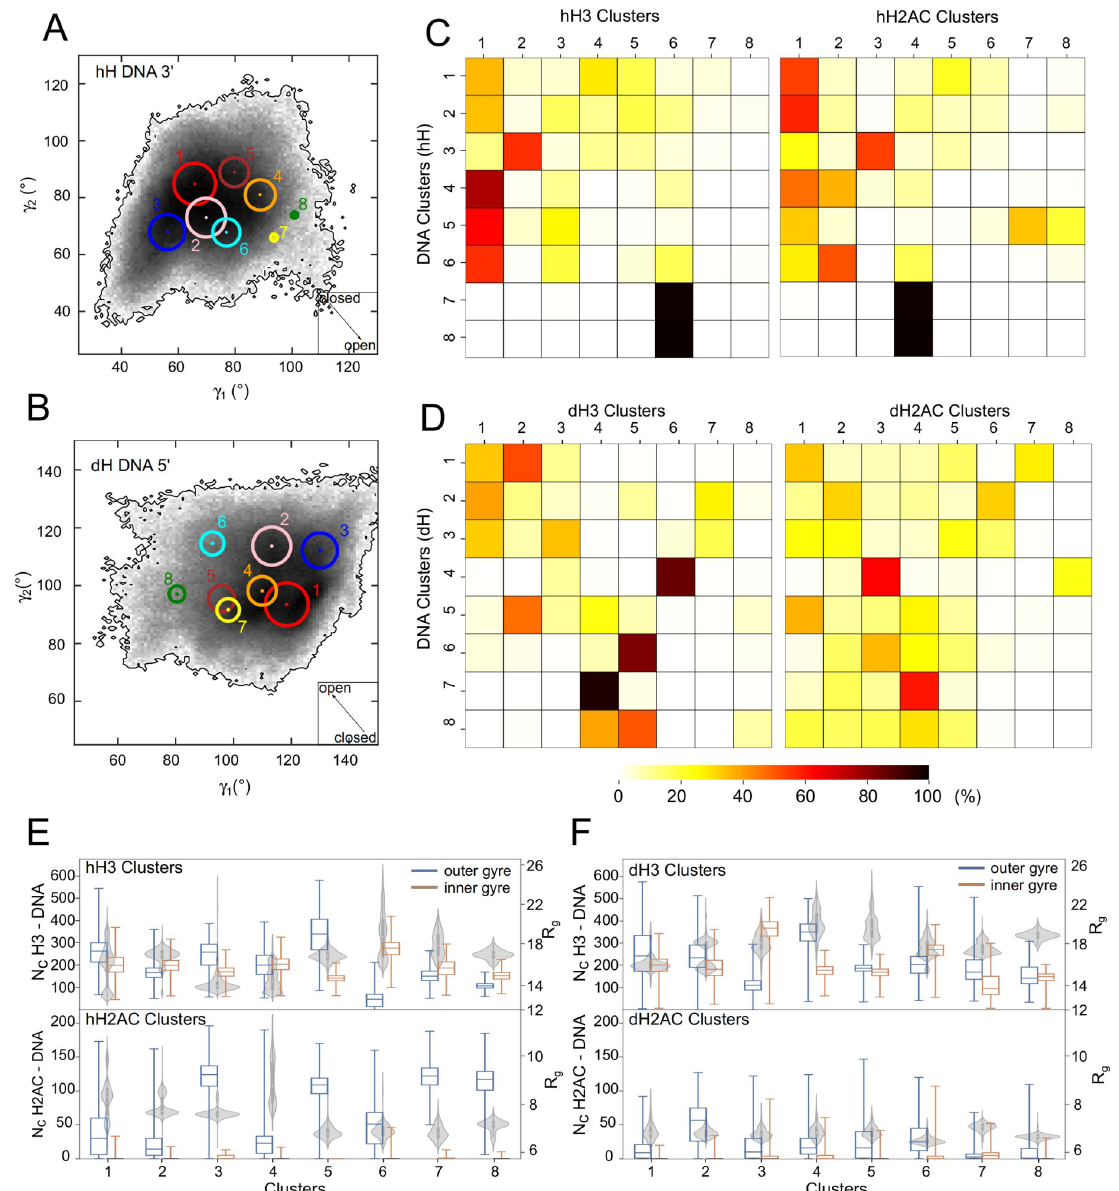
Fig 5. Clustering of the DNA and histone tails. (A-B) Position of the DNA cluster centroids in the 2D histogram of the γ distribution for the 3’ L-DNA in hH simulations (A) and 5’ L-DNA in dH simulations (B). The size of the circles indicates the size of the clusters. (C-D) Distribution of the frames from each DNA cluster on the tail clusters (H3 in the left matrix, H2AC in the right), for hH (C) and dH (D) simulations. For each DNA cluster (row), the cells are colored by the percentage of frames of that cluster that belong to the tail cluster (column). (E-F) Features of H3 and H2AC configurations per cluster in the hH (E) and dH simulations (F). Box plots indicate the number of contacts between H3 (top) or H2AC (bottom) tail and the inner (red) and outer gyre (blue) of DNA per tail cluster. Violin plots represent R g of the H3 (top) or H2AC (bottom) tail per